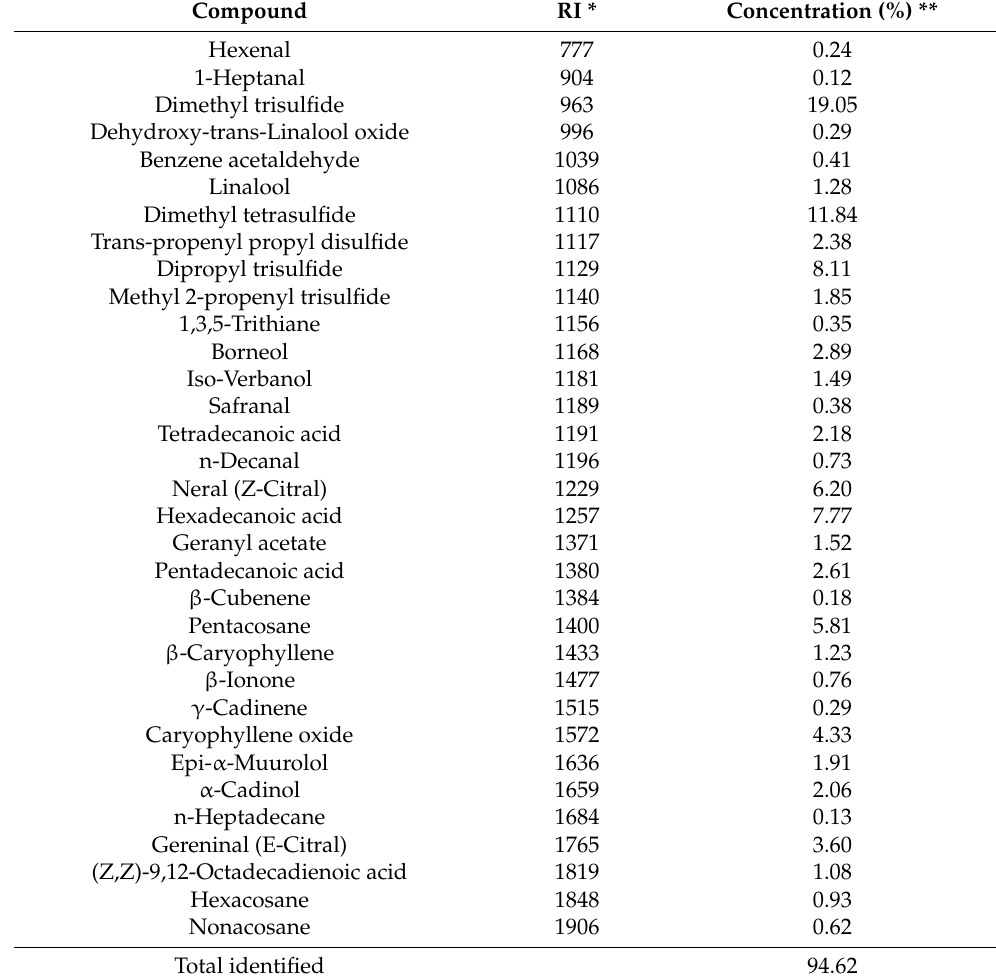
Table 1. Chemical composition of Allium jesdianum Boiss. EO